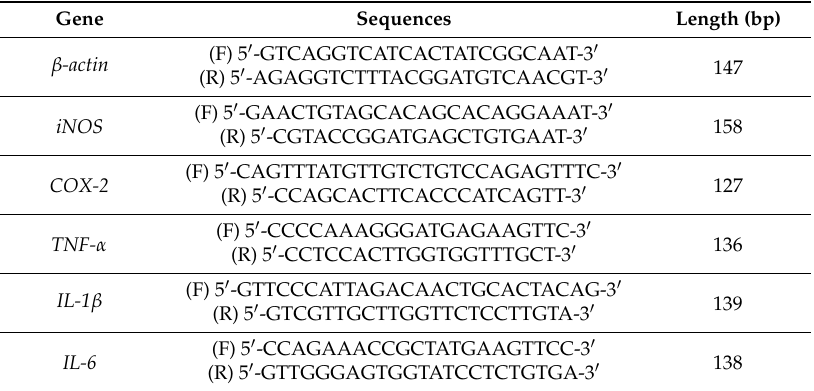
Table 1. The primers sequences of β -actin , iNOS , COX-2 , TNF- α , IL-1 β and IL-6 .